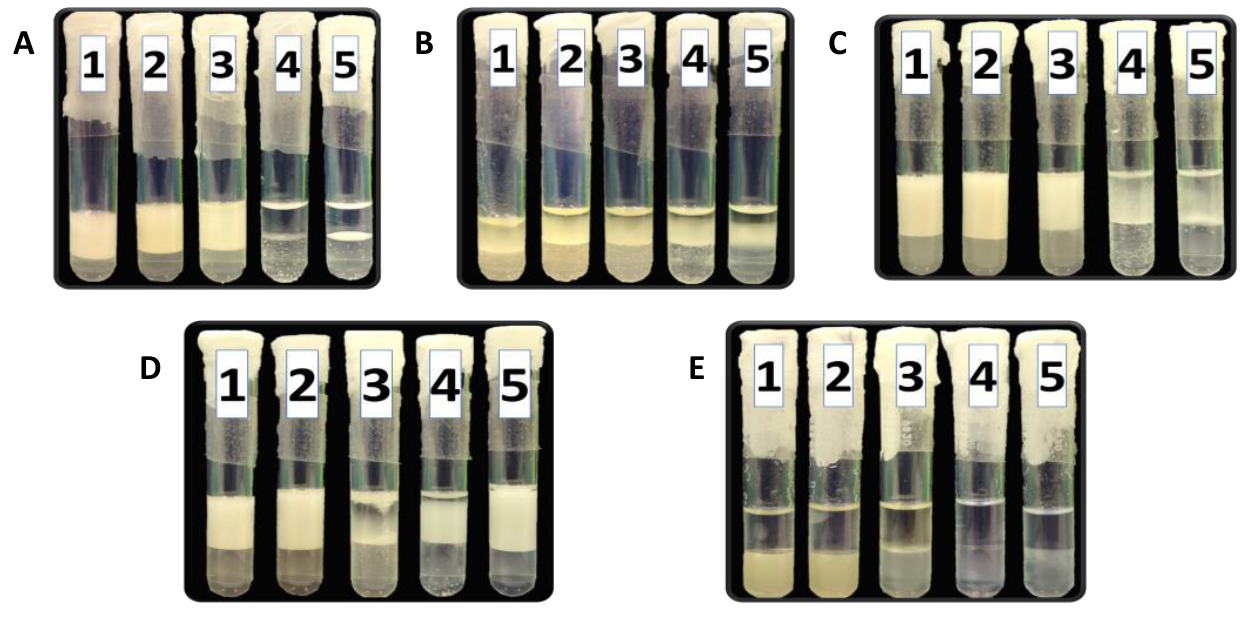
Figure 3. Emulsifying activity (E 24 ) of the supernatants resulting from growth with different C-sources (1. used olive oil; 2. raw olive oil; 3. used frying oil; and 4. glycerol), using different organic phases: ( A ) n-heptane; ( B ) olive oil; ( C ) frying oil; ( D ) gear oil; and ( E ) ethyl acetate. Ultrapure water was used as a negative control (5). Table 2. Emulsifying activity (E 24 ) of the supernatants resulting from growth with different C- sources (1. used olive oil; 2. raw olive oil; 3. used frying oil and 4. glycerol) against n-heptane, olive oil, Frying oil, Gear oil, and ethyl acetate as organic phase. Ultrapure water was used as a negative control (5).